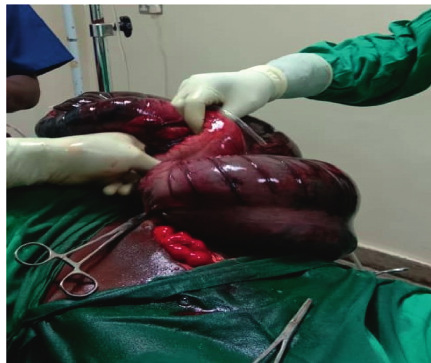
Figure 3: Gangrenous bowel discovered during exploratory